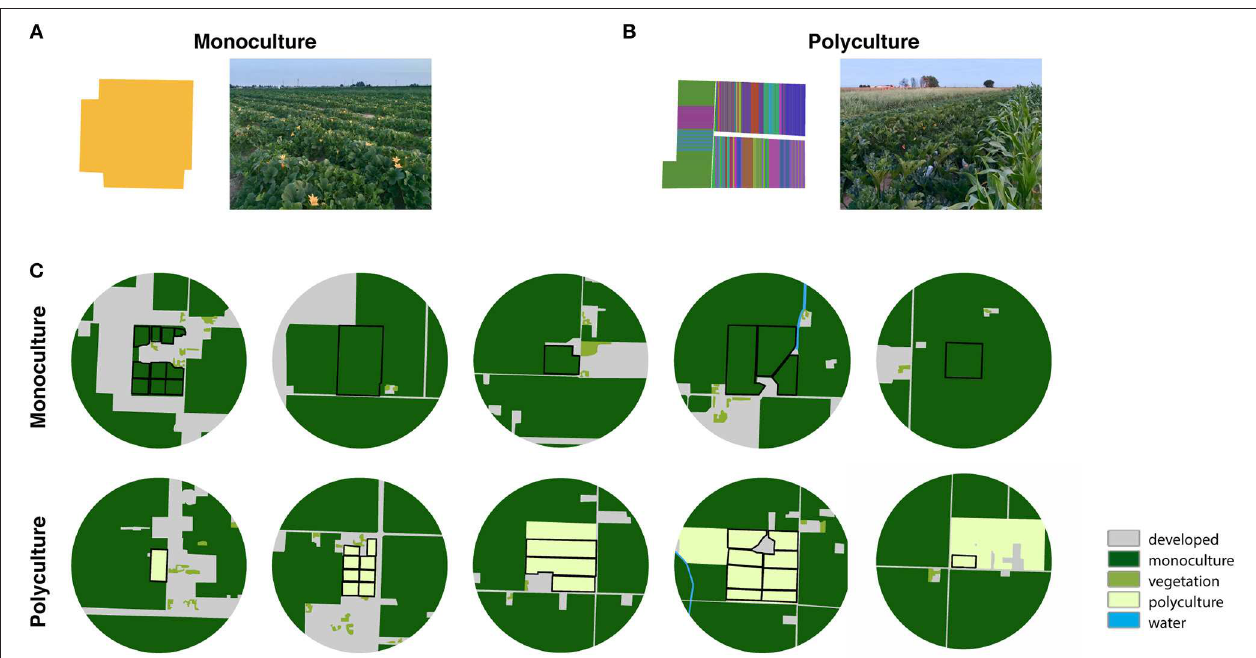
FIGURE 1 | Example photos and hand-digitized crop maps, in which each color represents a different crop type, of (A) a monoculture farm and (B) a polyculture farm to visualize the field-scale variation in the (C) landscape-scale maps (hand-digitized aerial imagery at 500m buffer from the farm center) of the monoculture and polyculture